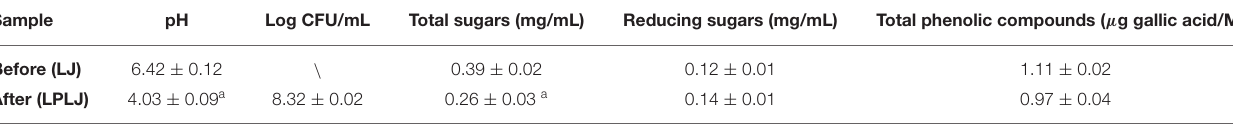
TABLE 2 | Changes of pH, CFU, total sugars, reducing sugars, and total phenolic compounds by fermentation.